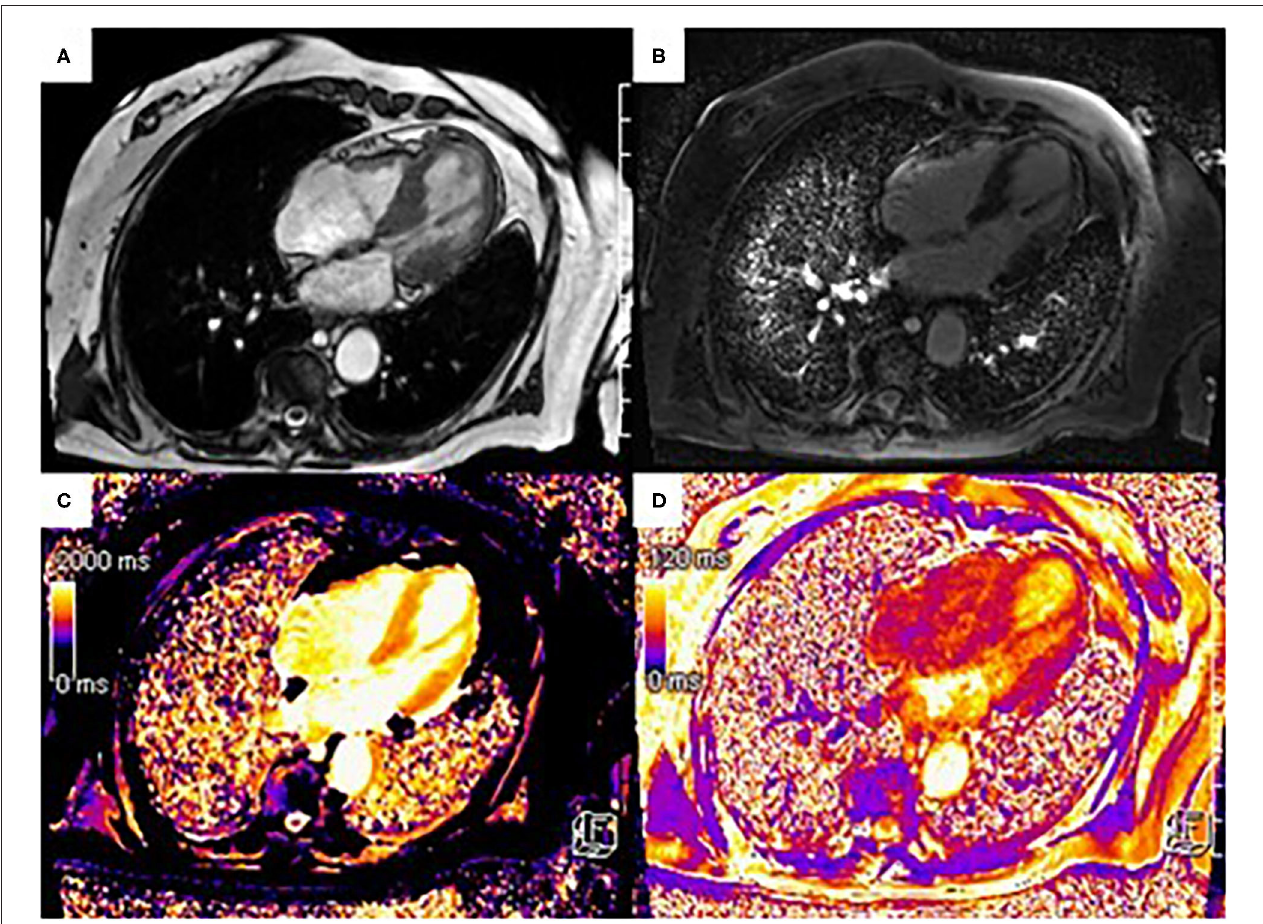
FIGURE 3 | 90-year-old patient presenting to the emergency department with chest pain, ST segment elevation in the anterior leads at electrocardiogram and elevated troponin levels. Urgent coronary angiography excluded obstructive coronary artery disease. Three Tesla cine Steady-State Free Precession sequence (SSFP) CMR showed akinesis of the apical segments with hypercontractility of the basal segments (A) , absence of LGE (B) and elevated native T1 mapping [1,400–1,550 msec (local reference range: 1,086–1,292 msec)] (C) and elevated T2 mapping values [50–55 msec (local reference range: 30–45 msec)] (D) in correspondence with the area of apical akinesia. Based on the clinical context and imaging findings, the patient was diagnosed with apical ballooning in the context of Takotsubo syndrome.